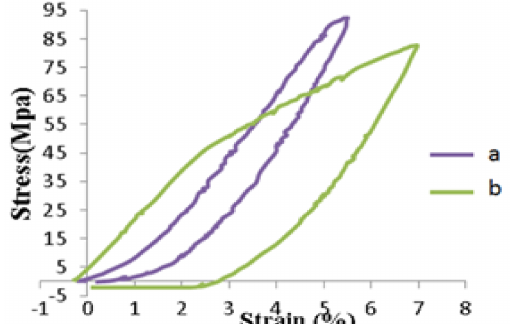
Fig. 3. DSC patterns of the sintered specimen at 800°C for 30 min (a), and the sintered specimen at 800°C for 120 min (b).